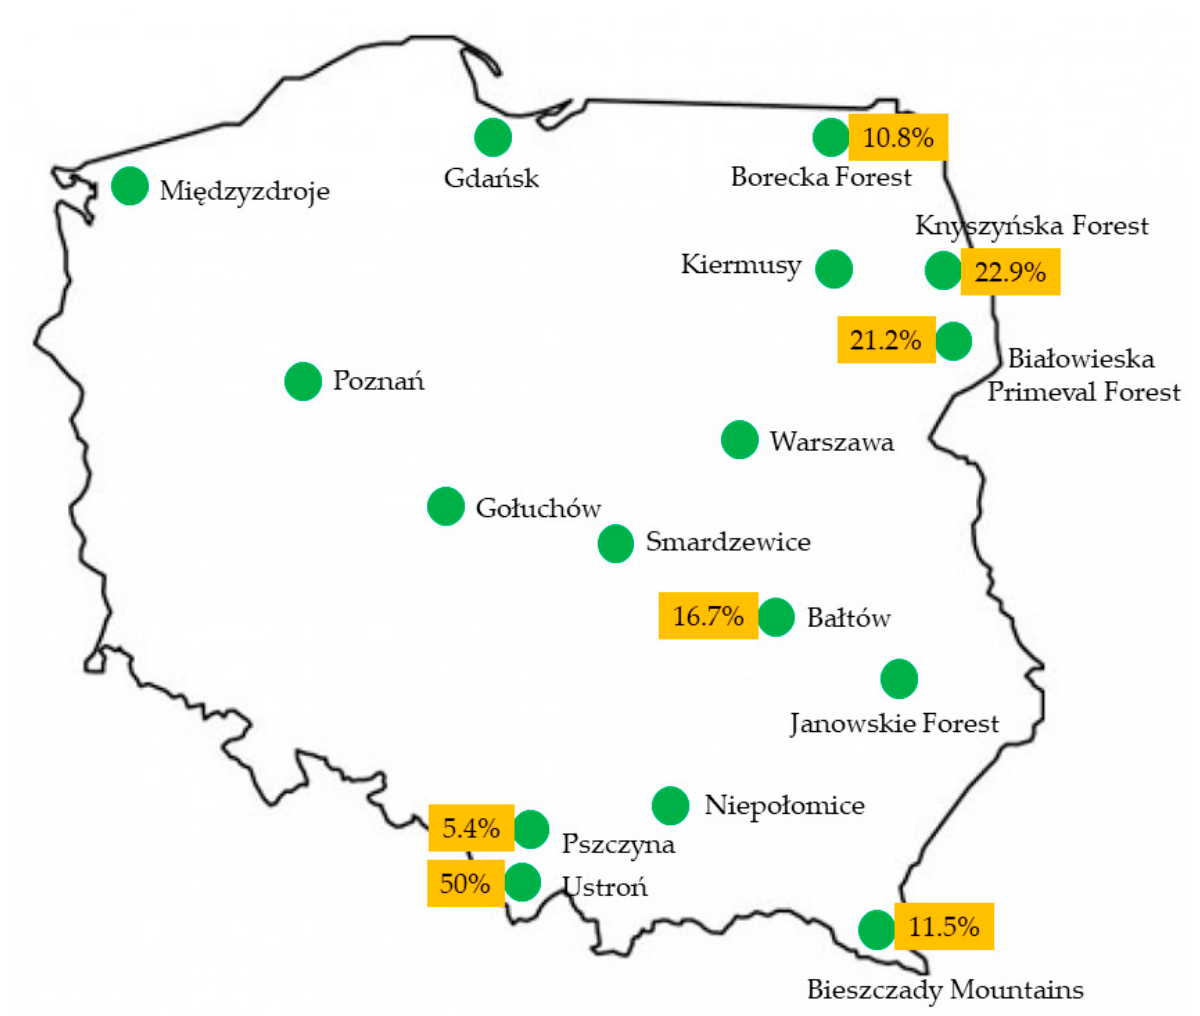
Figure 1. The location of herds of European bison in Poland (marked by green circles) from which the samples were collected. The prevalence of T. pyogenes infections in the studied areas was added in the yellow rectangles.